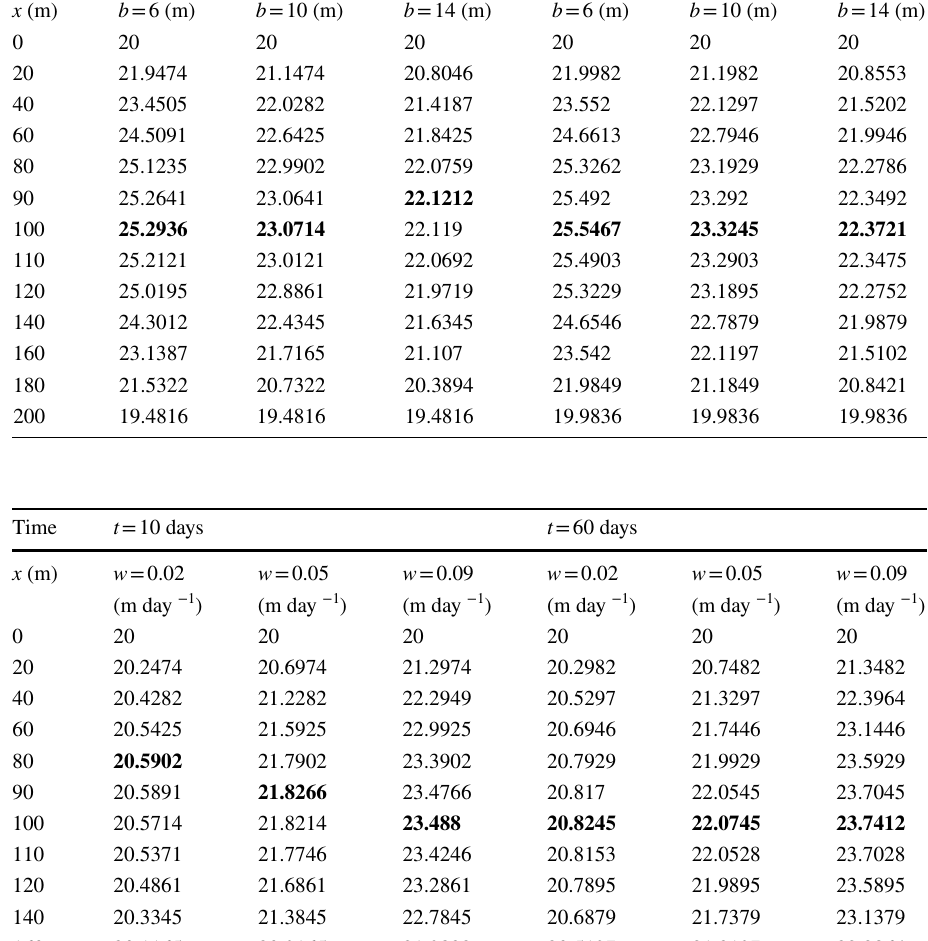
Table 3 The effect of variation in thickness ( b ) on the groundwater hydraulic head at t = 10 days and t = 60 days